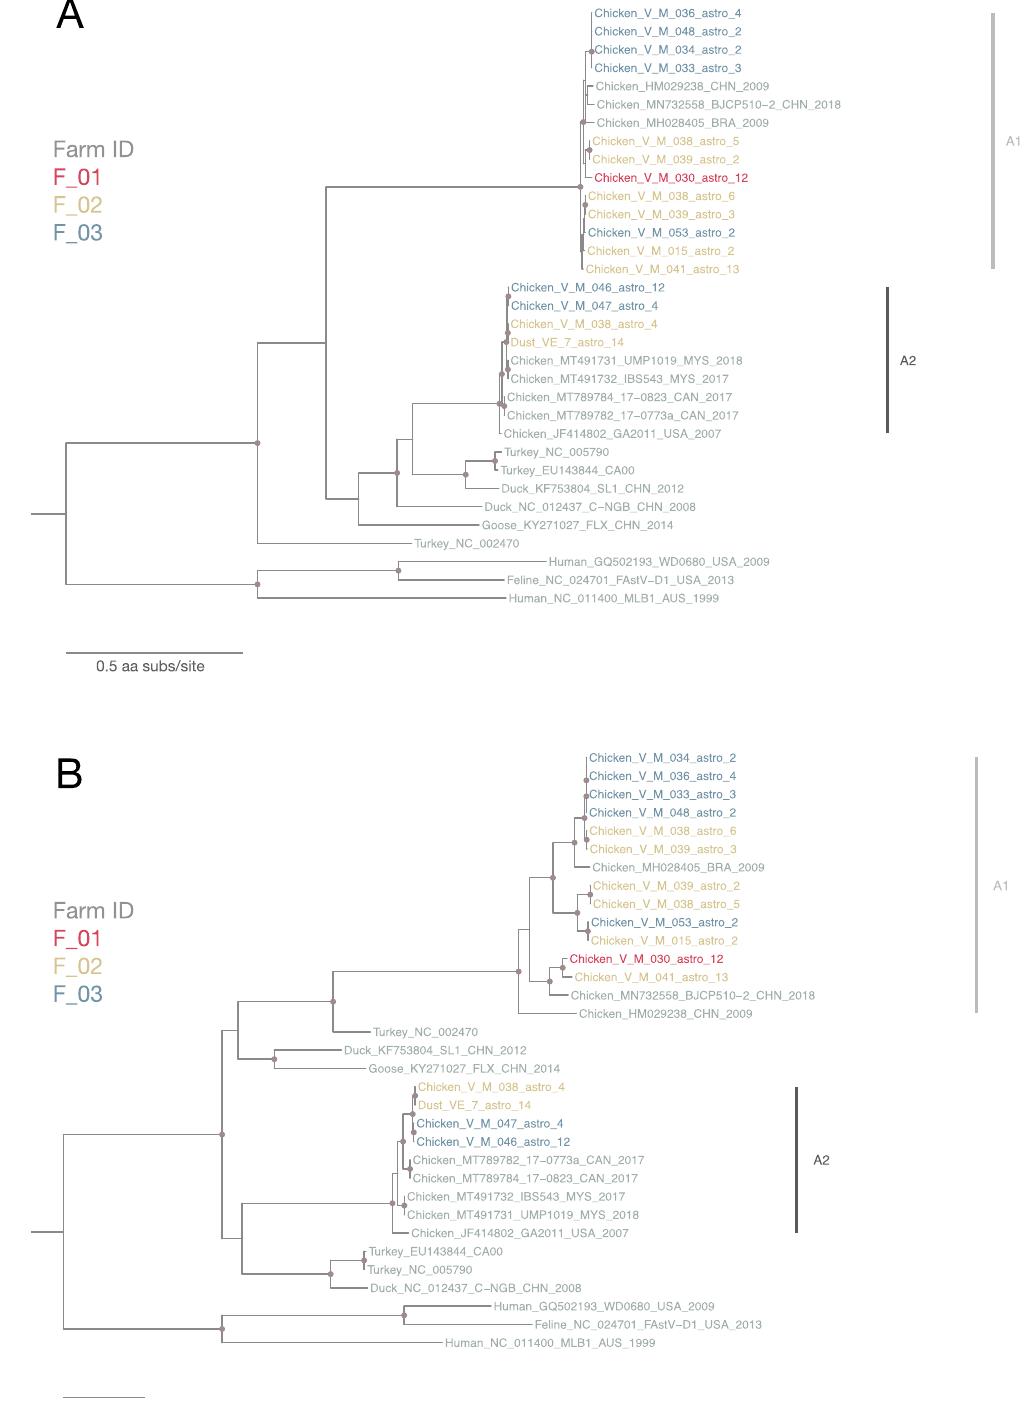
Figure 5. ( A ) Maximum-likelihood phylogenetic tree of 33 astrovirus partial RdRp amino acid sequences (sequences from this study: 16; reference sequences: 17; 548 sites) reconstructed using a best-fit evolutionary model LG + FC + I + G4m. ( B ) Maximum-likelihood phylogenetic tree of 33 astrovirus partial capsid amino acid sequences (sequences from this study: 16; reference sequences: 17; 908 sites) reconstructed using a best-fit evolutionary model LG + FC + I + G4m. For clarity, only bootstrap supports > = 70 are shown as a light brown node point. Tip labels of our samples are color-coded by corresponding farm ID. Reference sequences are in grey and tree was mid-point rooted for